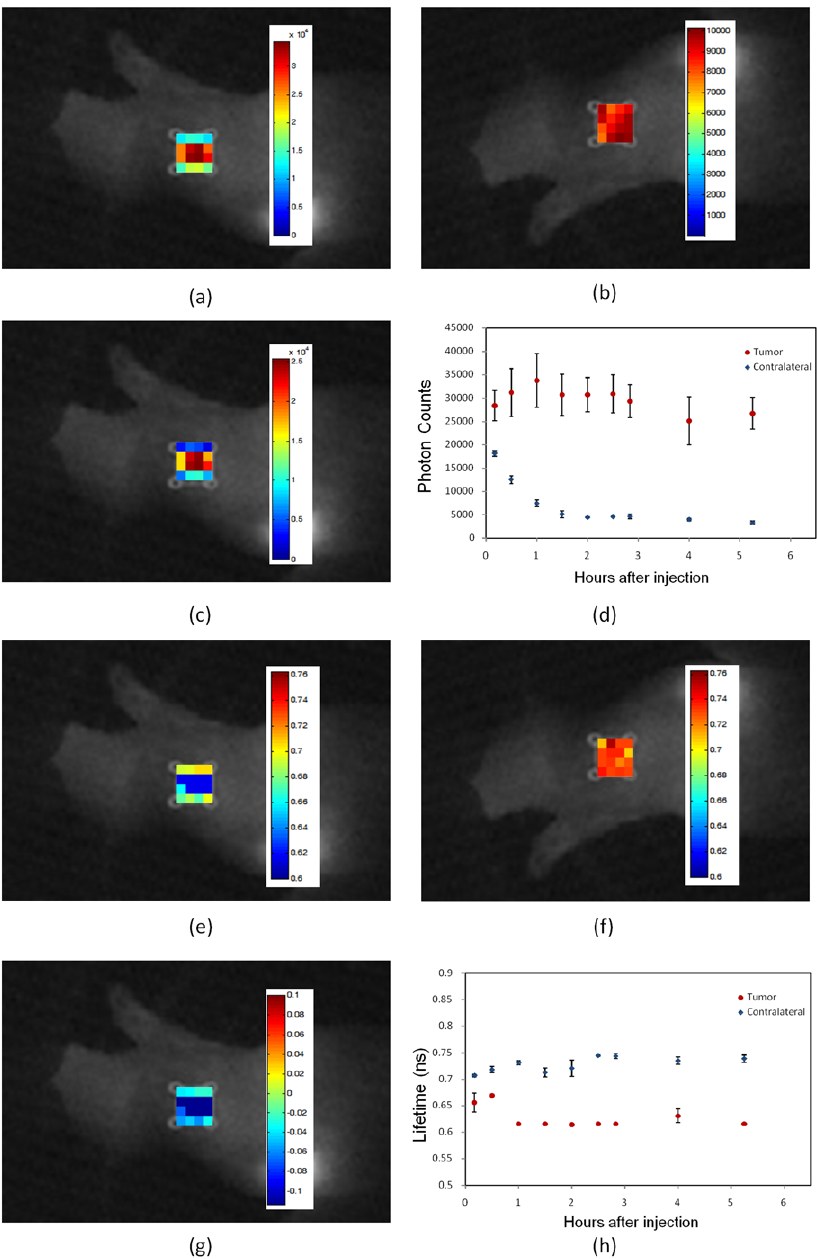
Figure 6. Invivo fluorescence imaging of xenograft mouse with high HER2-expressing human tumor model (NCI-N87) after injection of the HER2 specific Affibody H (His6-Z HER2 :GS-Cys) conjugated to Dylight750. ( A ) Fluorescence intensity map at the tumor region. ( B ) Fluorescence intensity map at the contralateral site. ( C ) The difference of fluorescence intensity at the tumor region and the contralateral site, mapped on the tumor region. ( D ) Pharmacokinetics of the fluorescence intensity at the tumor region and contralateral site after the injection over time. The data in Figs. ( D ) and ( H ) are the average data of three mice. Markers show the average and bars show the standard deviation. ( E ) Fluorescence lifetime map at the tumor region. ( F ) Fluorescence lifetime map at the contralateral site. ( G ) The difference of fluorescent lifetime at the tumor and the contralateral site mapped on the tumor region. ( E ) Pharmacokinetics of the fluorescent lifetime at the tumor region and contralateral site after injection over time.